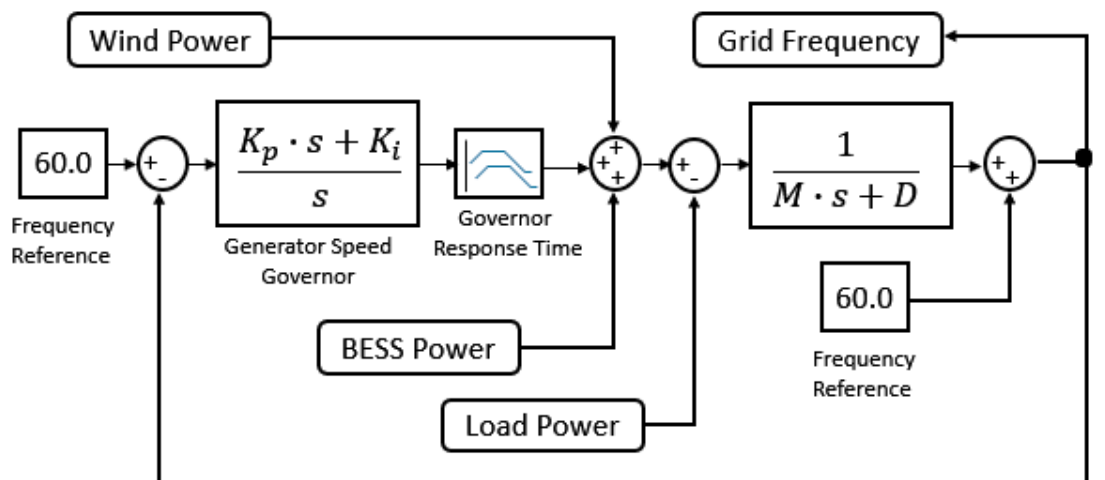
Figure 5. Schematic of the simple model of the Hawaii island grid, which was used to develop the frequency response algorithm.